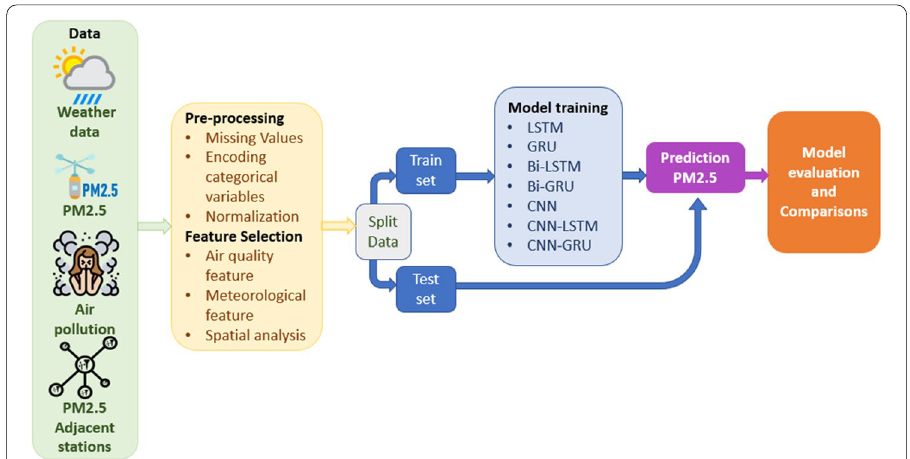
Fig. 11 Workflow for predicting PM 2.5